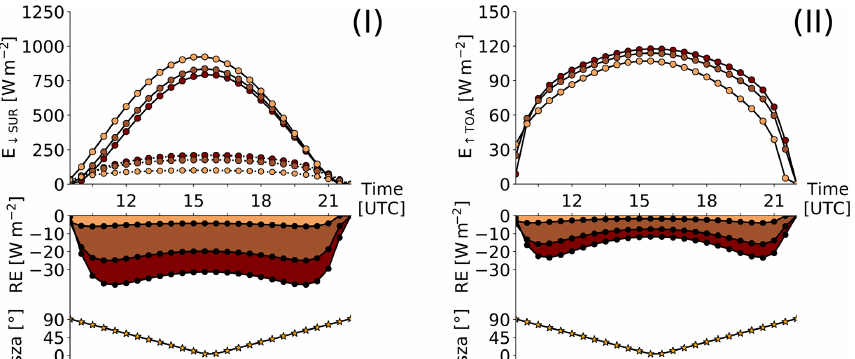
Figure 5. Top: diurnal cycles of the modeled down-welling short-wave irradiances at surface level (I – E ↓ SUR : direct (solid), diffuse (dashed)) and up-welling short-wave irradiances at the top of the atmosphere (II – E ↑ TOA ). Due to the different measurement locations and small differences in corresponding solar zenith angles (sza), calculated curves are slightly shifted along the x axis. Bottom: the corresponding diurnal cycles of the modeled Saharan dust short-wave radiative effects (RE) at surface level (I) and the top of the atmosphere (II). A representative sza for the whole measurement region is shown at the bottom (11 ◦ N, 55 ◦ W). Colors indicate the three cases: light orange (case a), orange (case b) and dark orange (case